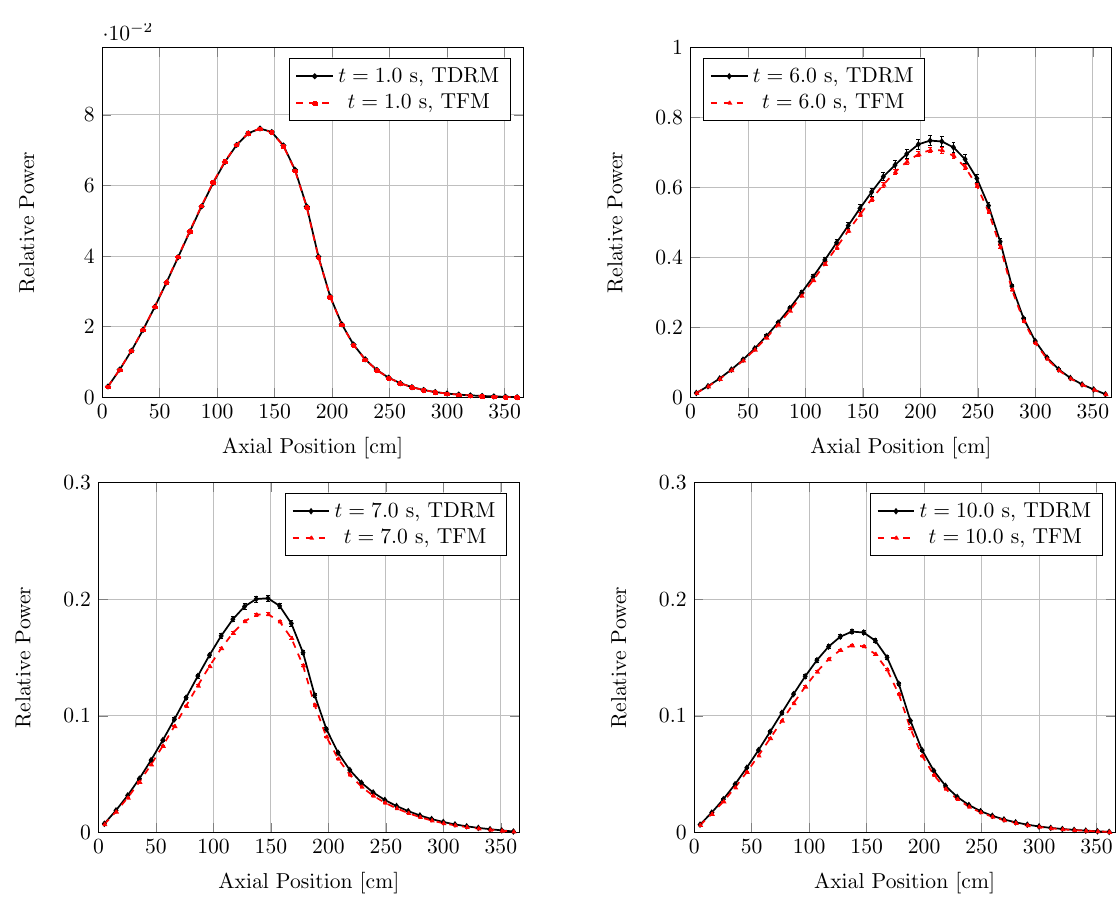
Figure 3: Evolution of relative fission source rate distribution during the absorber bank withdrawal